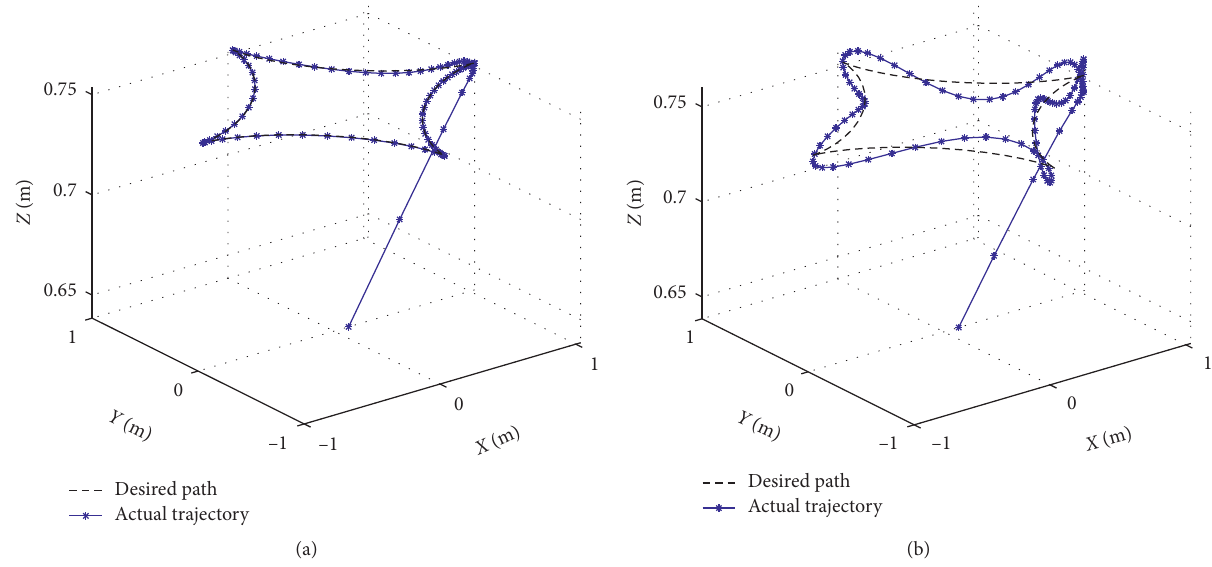
Figure 5: Desired path and actual trajectory synthesized by two models in the presence of vector-form noise. (a) Disturbed EVPNN model (33). (b) Disturbed ZNN model